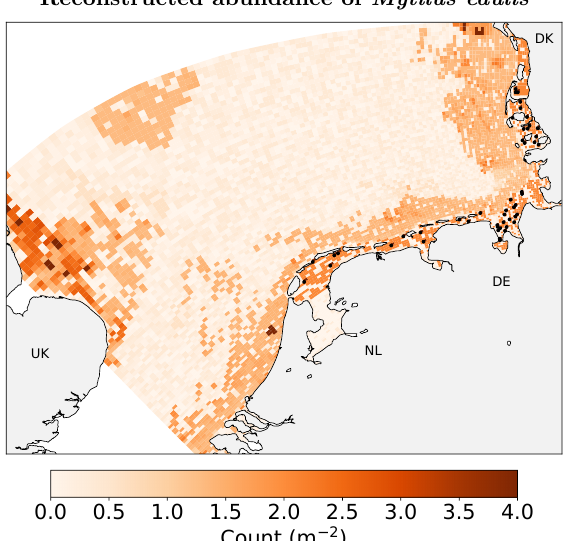
Figure 1. Reconstructed spatial distribution of Mytilus edulis abundance in the southern North Sea. The reconstruction is based on Global Biodiversity Information Facility (GBIF), Ocean Biogeographic Information System (OBIS), Archive for Marine Species and Habitats Data (DASSH), Belgian Marine Data Centre (BMDB), and oint Nature Conservation Committee (JNCC) presence-only as well as count data for M. edulis ; the spatial distribution was informed by depth and sediment grain size and scaled to survey data in the Wadden Sea. The locations of mussel beds are shown as black